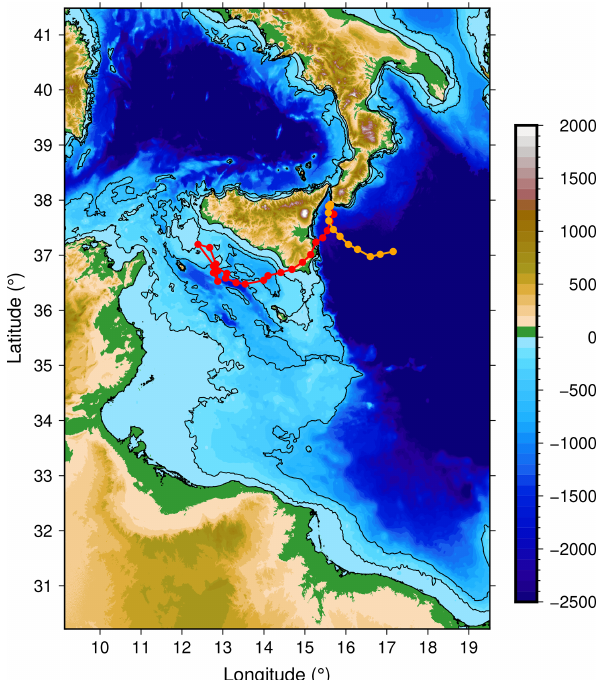
Figure 1. Map of the domain and bathymetry (m) used in the coupled simulation. The contours indicate the 100 and 500m iso- baths. The track of the simulated medicane is indicated in red until 00:00UTC on 8 November and in orange after that.